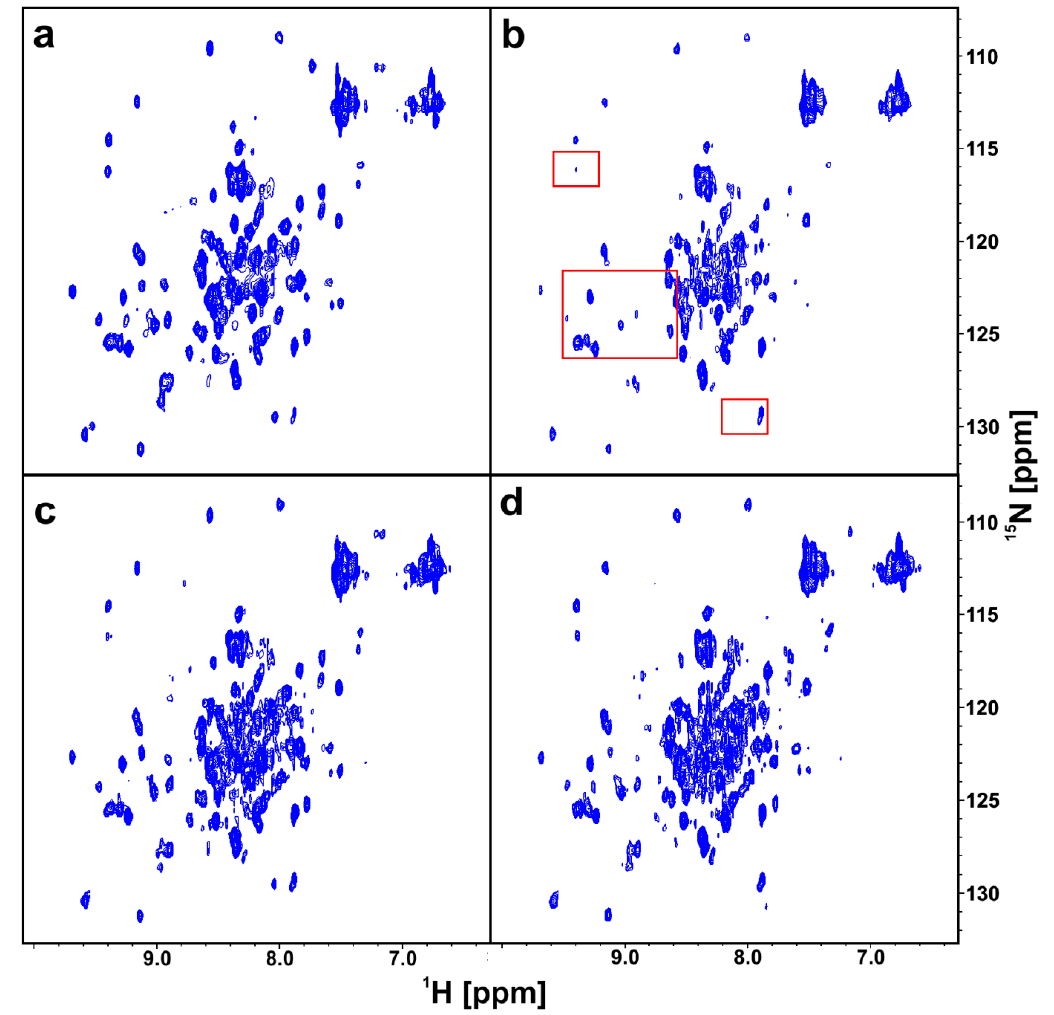
Figure 5. The 2D AIDA NMR for the mutant-PD-1/PD-L1 complexes. The spectra of apo-(N66A)PD-1 ( a ), the complex of (N66A)PD-1/PD-L1 with marked frames in red the most changing parts of the spectrum ( b ), the complex of (N66A)PD-1/PD-L1 with 5 ( c ), and 6 ( d ) in the molar ratio of the protein complex to the compound 1:1, respectively.